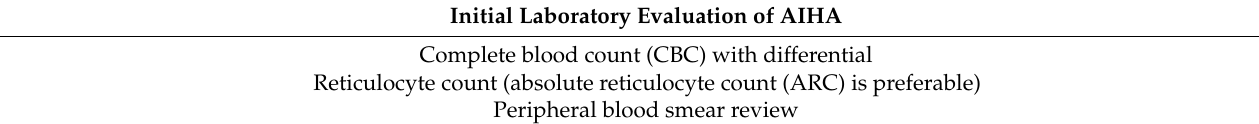
Table 3. Diagnostic evaluation of children with AIHA.